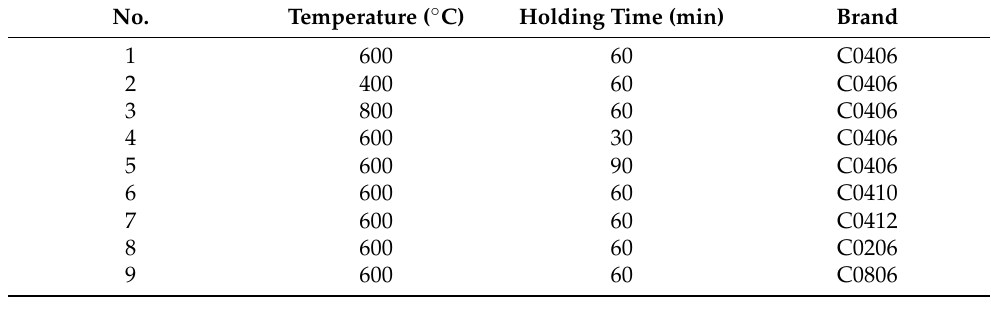
Table 4. Orthogonal scheme for the element diffusion experiment.